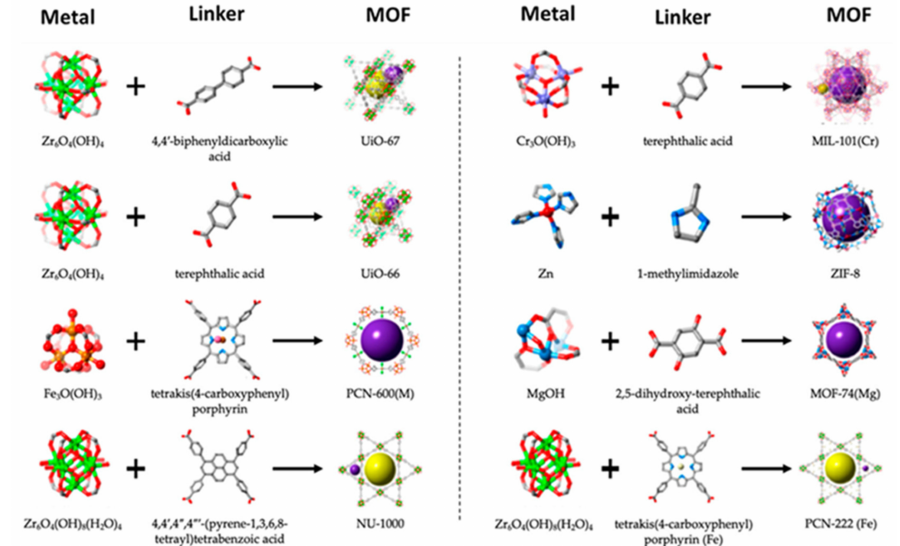
Figure 1. Schematic illustration of the molecular structure of common metals and ligands and the MOFs resulting from their combination.